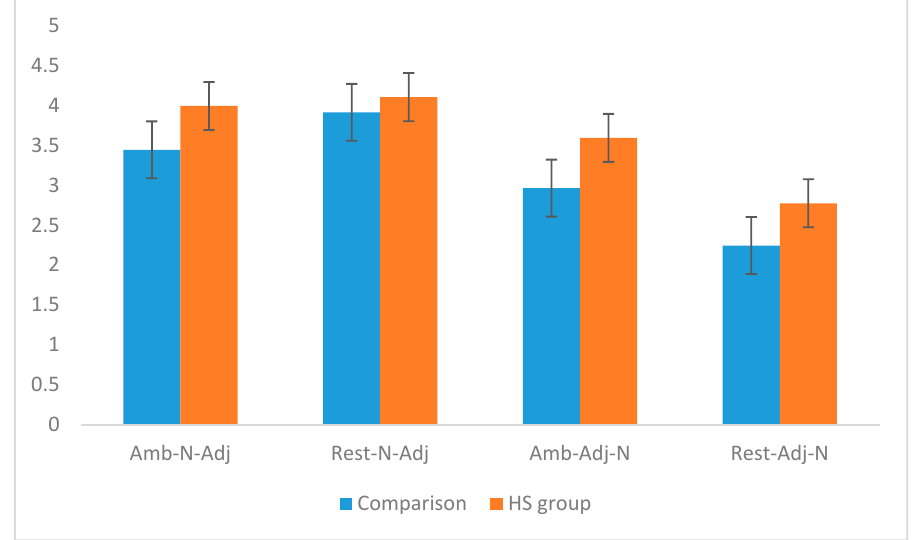
Figure 2. Mean ratings by Adjective-type, Position, and Group.